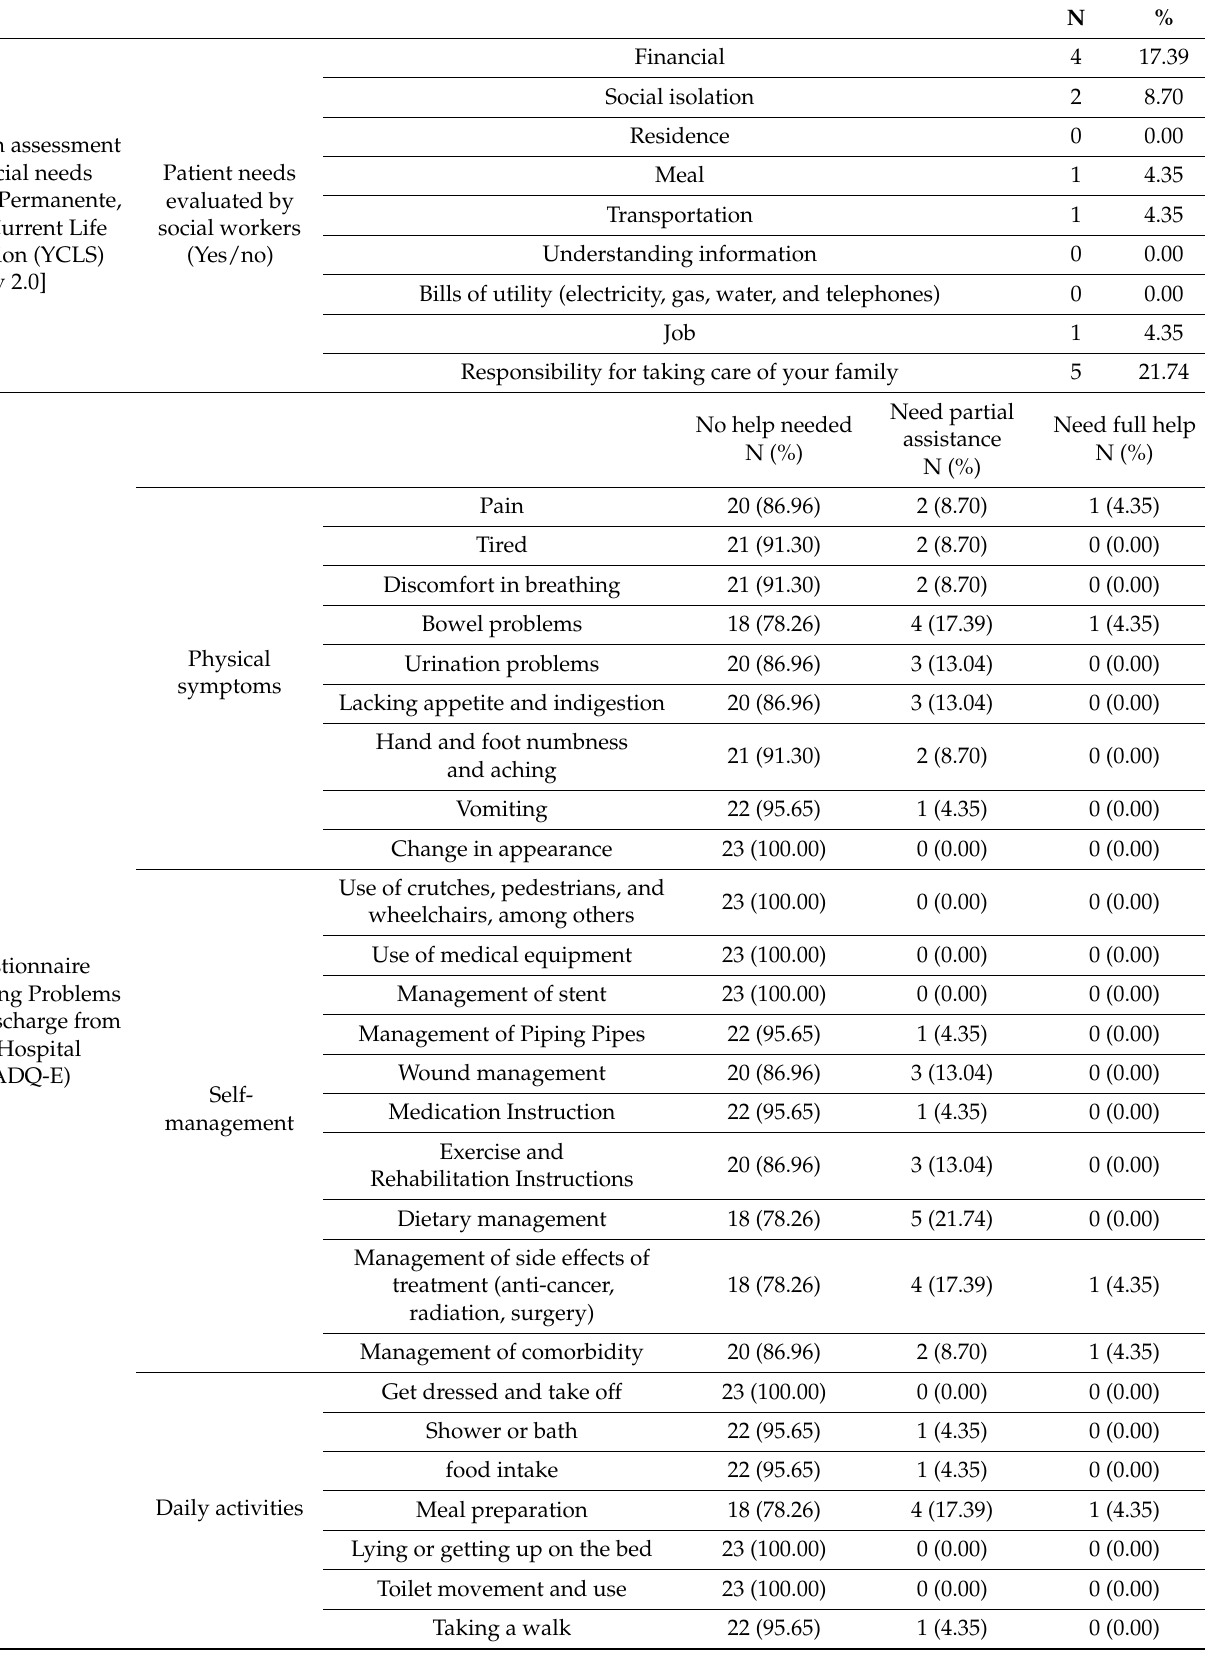
Table 3. In-depth Evaluation